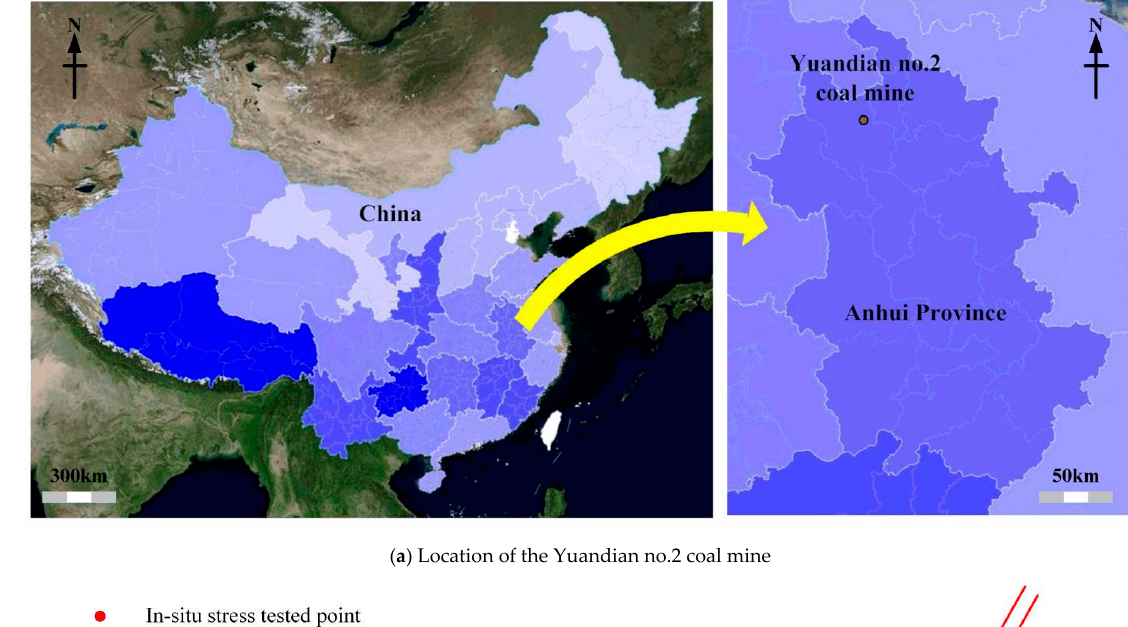
( c ) Schematic diagram of longitudinal section Figure 1. Simplified map of Yuandian no.2 coal mine and layout of the test roadway.